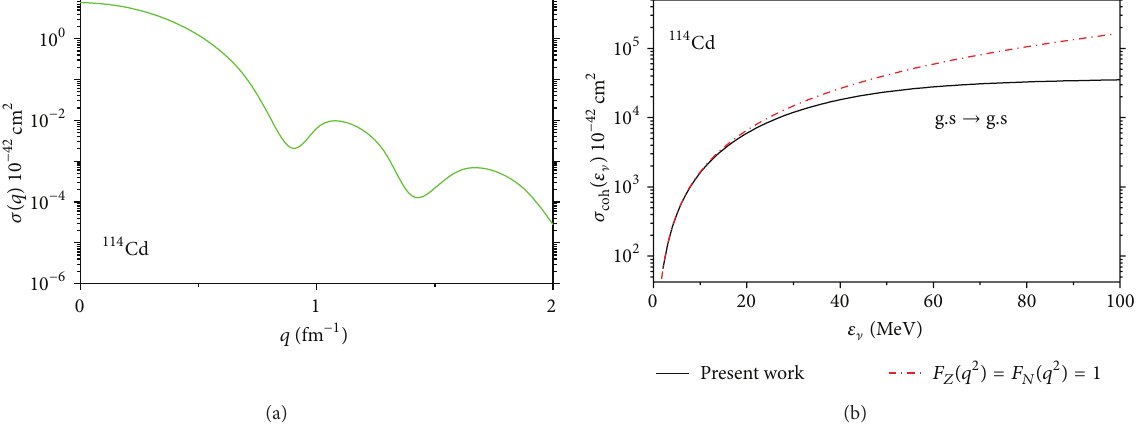
year, and 𝜏 1/2 = 1.28 × 10 9 year, resp.). In this